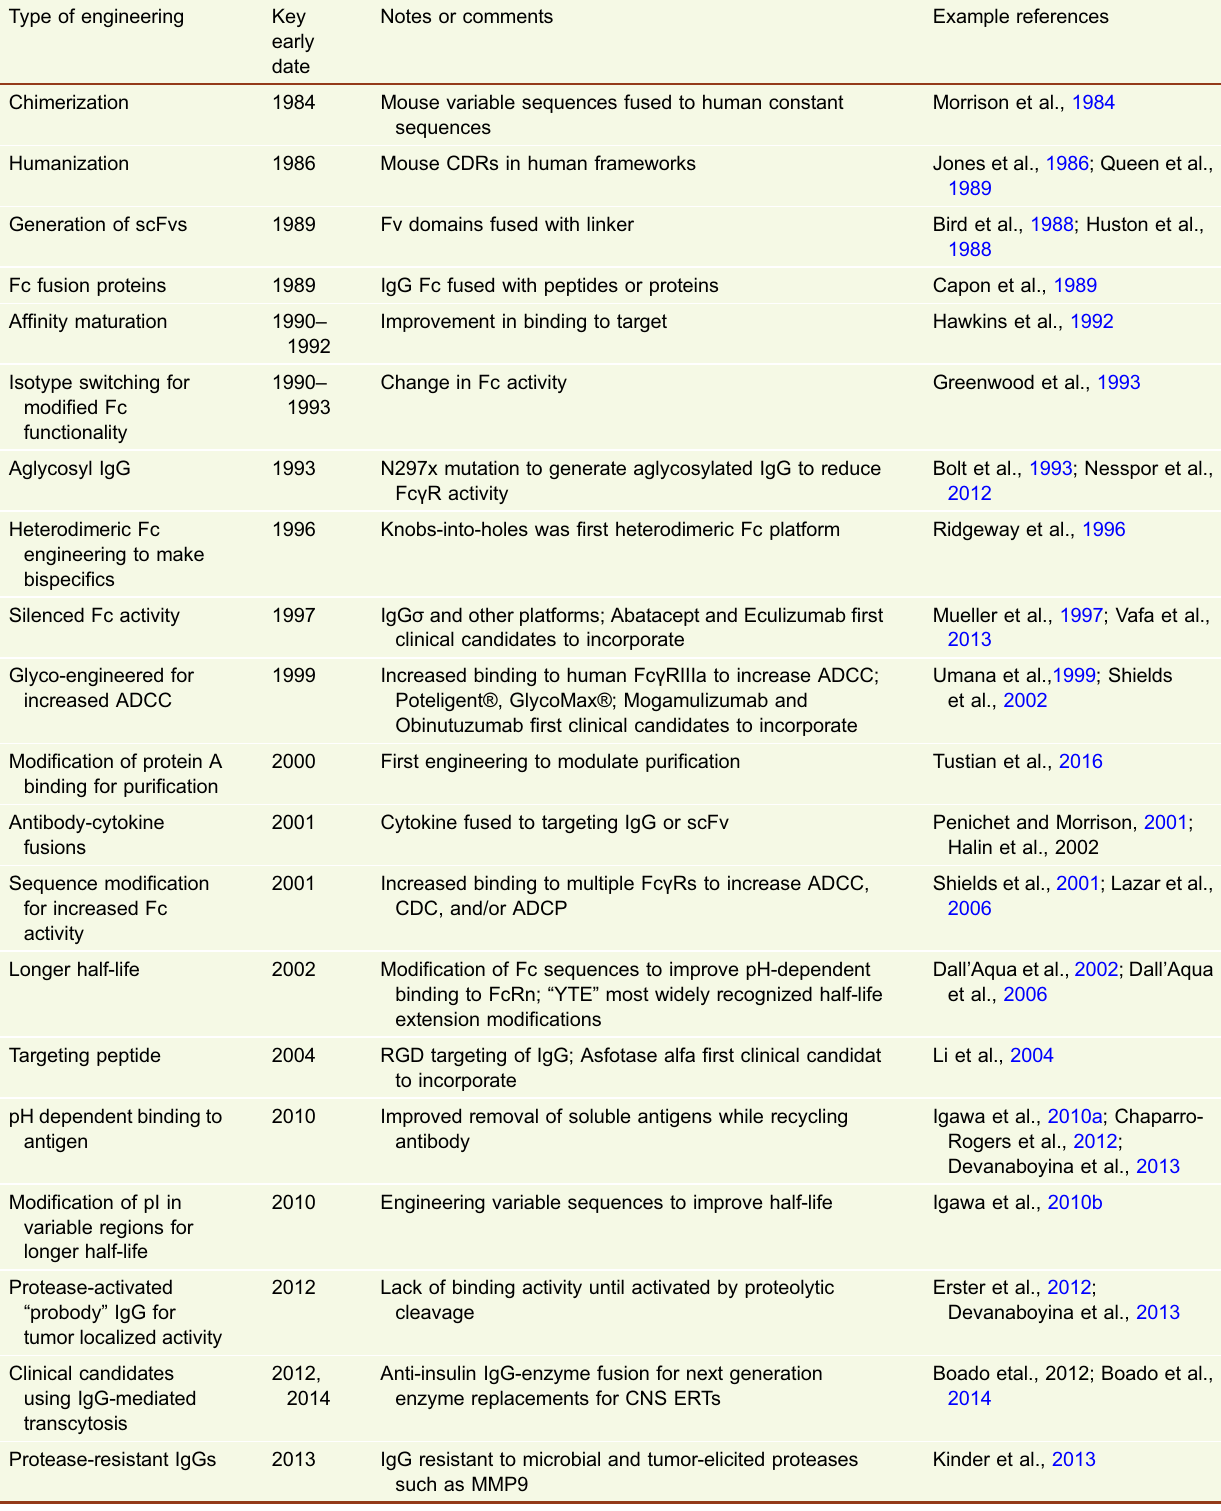
Table 8. Examples of antibody engineering and key early dates for the various technologies developed Type of